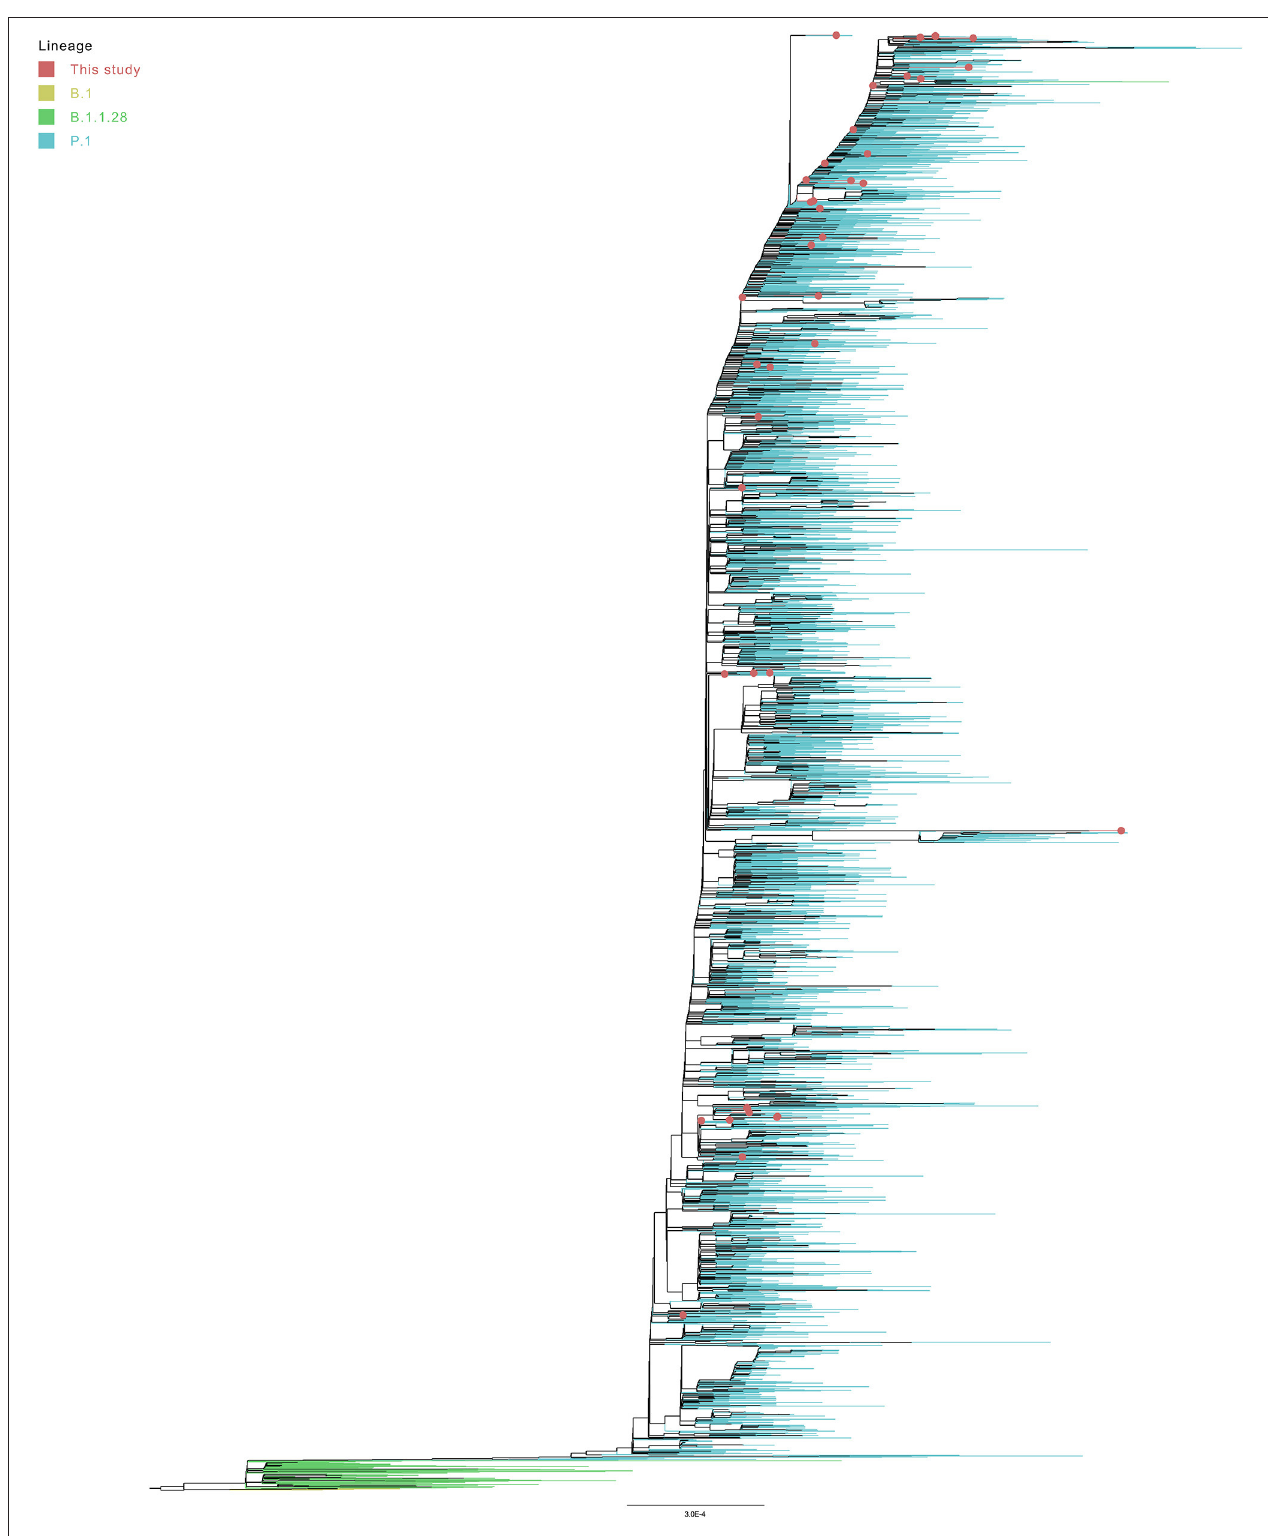
FIGURE 7 | Global phylogeny of 4,997 subsampled genomes from P.1 and B.1.1.28 lineages.